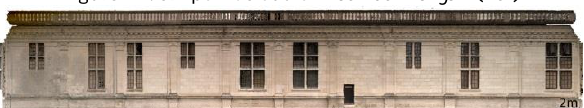
Figure 11: 3D point cloud of Tour du Donjon (TO)